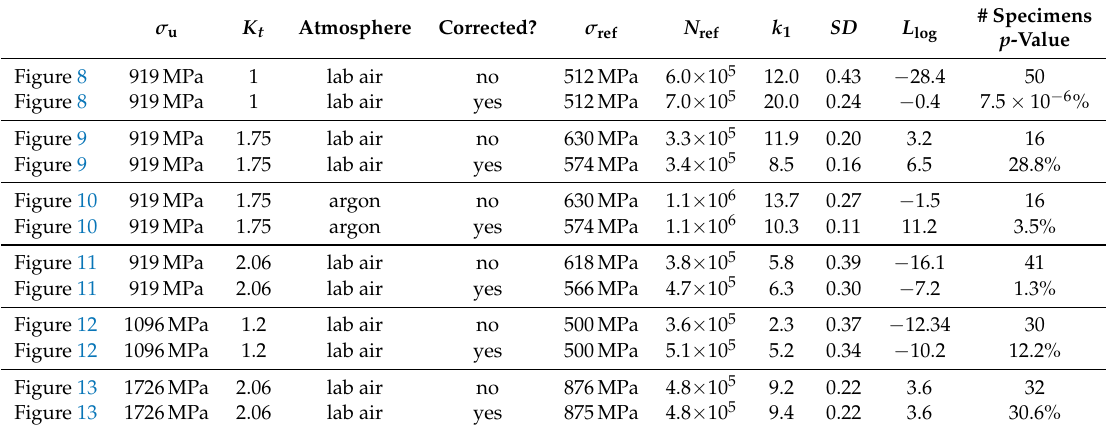
Table 4. Parameters, log-likelihood values of fitted fatigue curves as well as number of specimens and p -values obtained in t